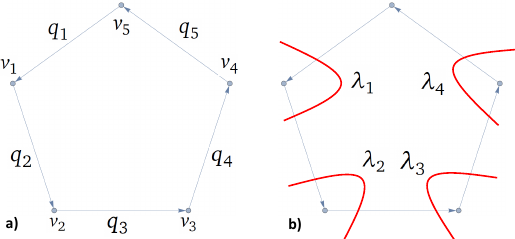
Figure 1: a) Feynman graph representing a pentagon, with the multi-edge and vertex labelling used in the analysis presented in the text. b) Example of an allowed causal entangled threshold contributing to the LTD causal